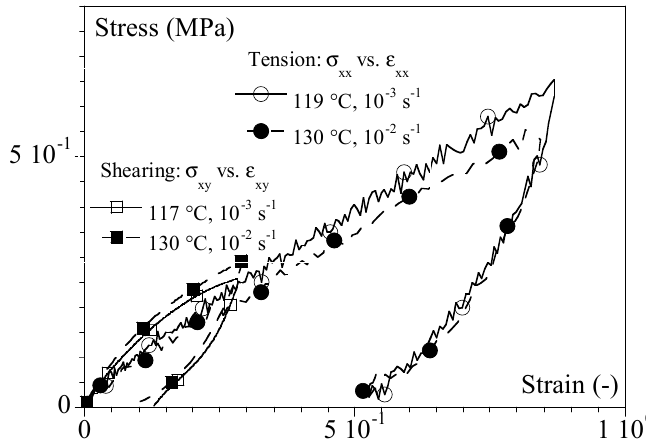
7 of 16 Figure 3 . Comparison between PMMA 3500 (plain lines) and PMMA 80 (hashed lines) for similar equivalent strain rates at T_ α : (1) PMMA 3500—118 °C and 0.01 s − 1 and PMMA 80—97 °C and 0.01 s − 1 ;